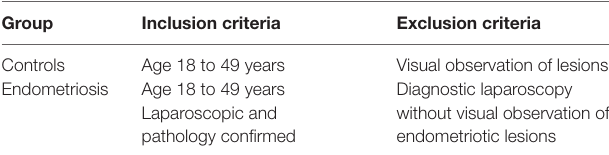
TABLE 1 | Inclusion and exclusion